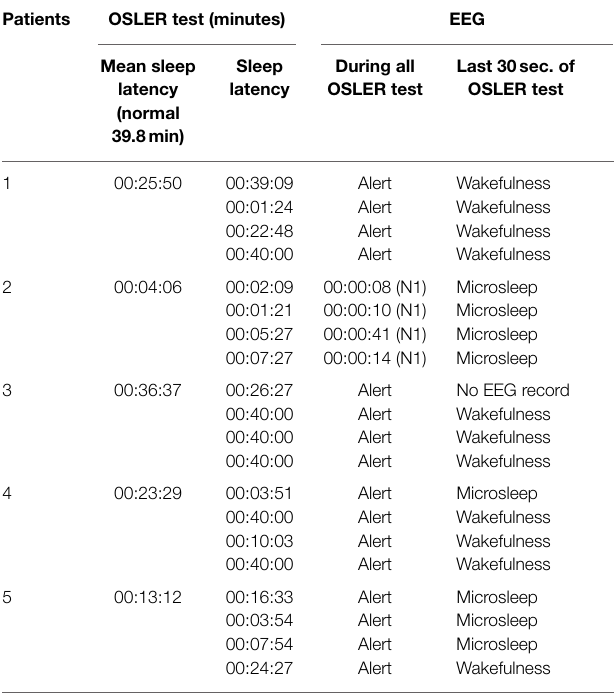
TABLE 3 | OSLER tests results with simultaneous neurophysiological records